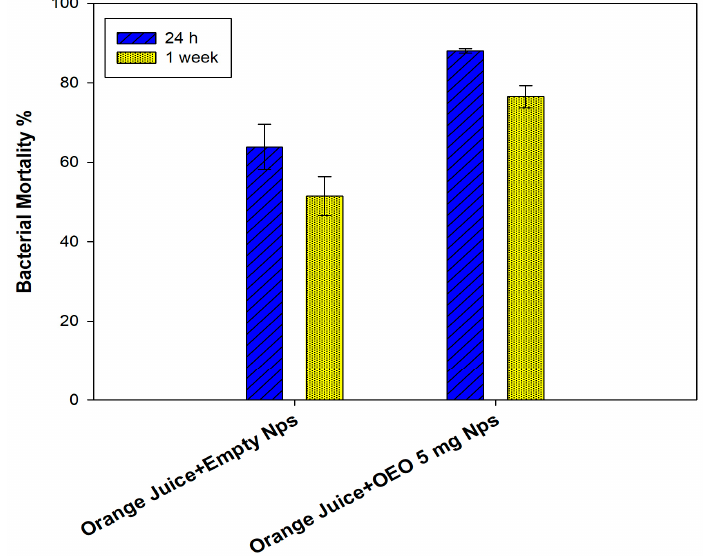
Figure 10. Bacterial mortality of E. coli after 24 h and after one week incubation at 25 °C with empty NPs and NPs-loaded 5 mg of OEO. Data represented as a percentage are the results of six different tests compared to the control (untreated E.coli ).